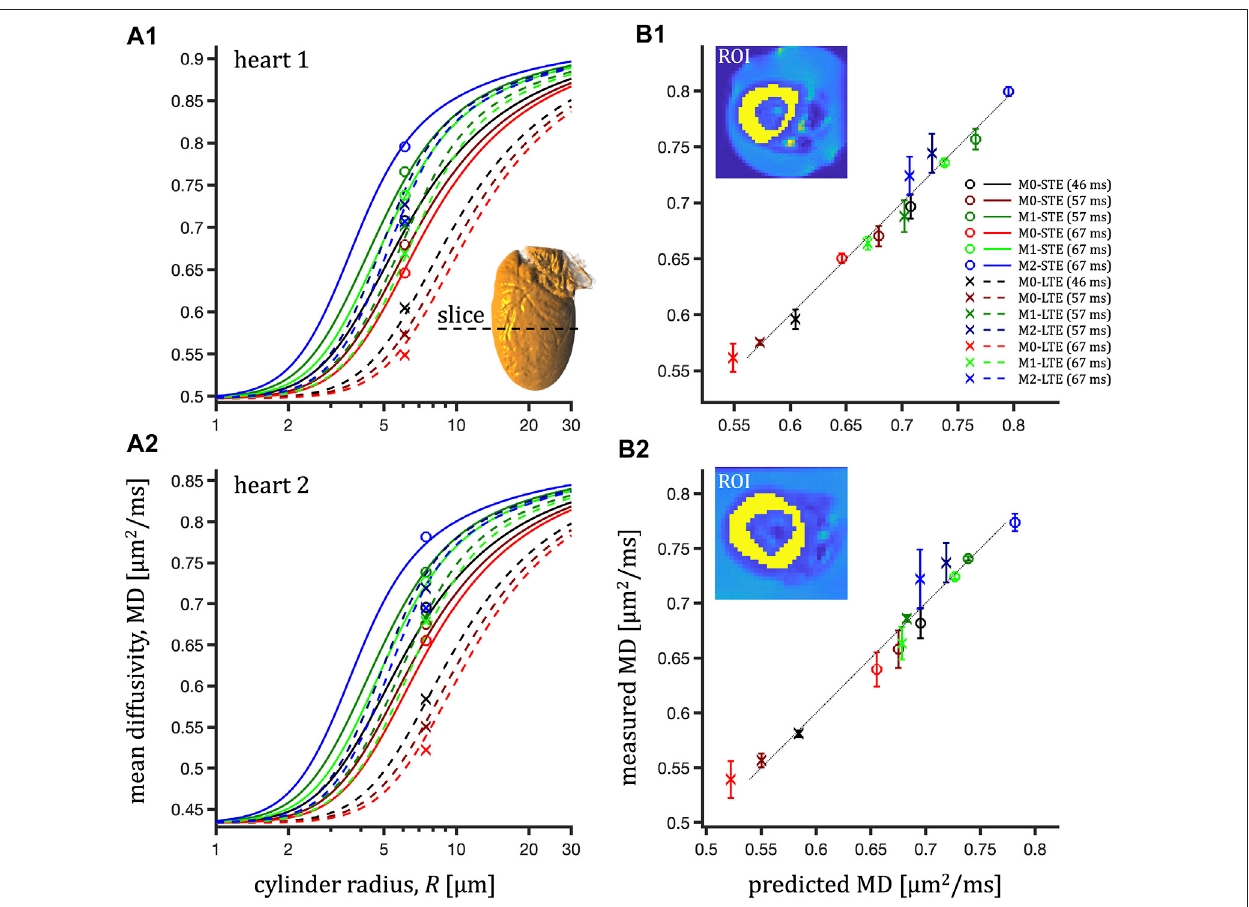
FIGURE 5 | ROI-average mean diffusivity in the left ventricle myocardium in the central slice (short-axis view) of two pig hearts (1, 2-bottom) and prediction of the hindered-restrictedmodel.Leftcolumn (A1,A2) :measuredMD(markers)andprediction(lines)vs.cylinderradius, R .Rightcolumn (B1,B2) :measuredMDvs.prediction with error bars corresponding to the distance between measurement and prediction (dotted line for unity relation).